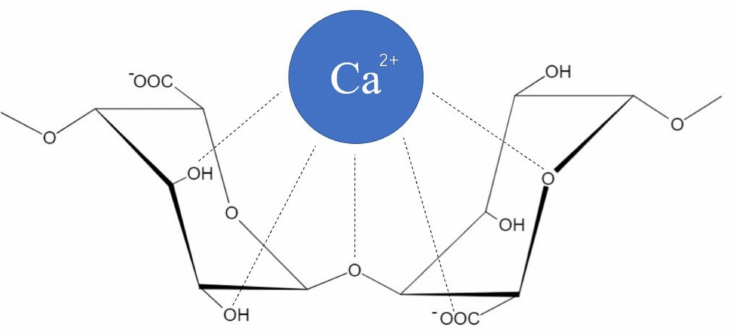
Figure 3. Interaction between divalent cation and G monomers of alginate in the “egg − box